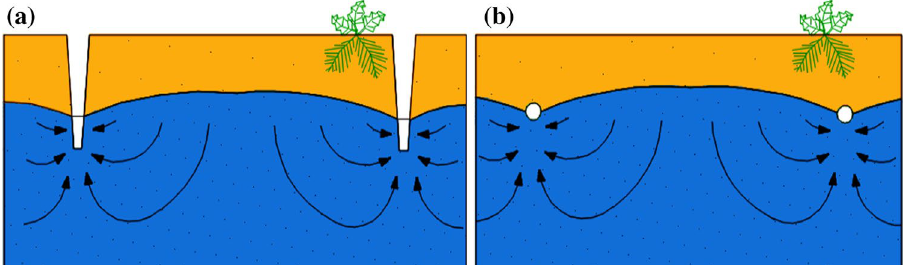
Fig. 2 Subsurface drainage by